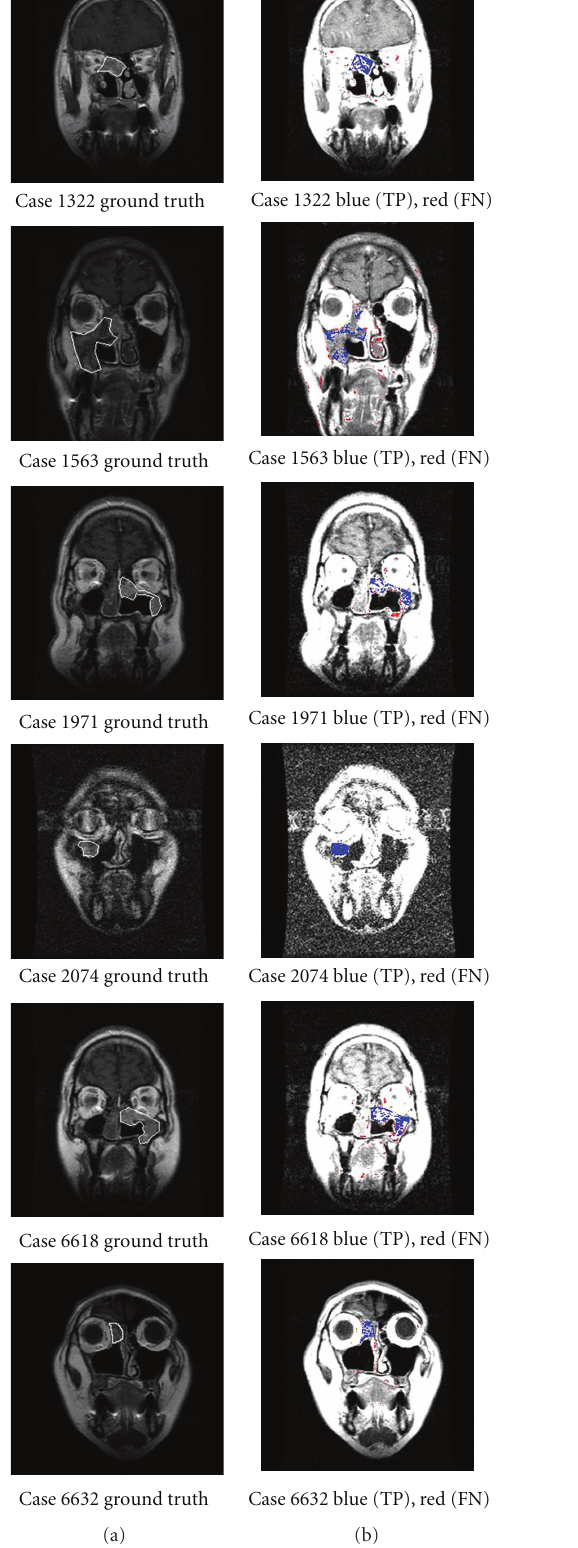
Figure 2: AdaBoost detection results. (a) Ground truth; (b) color blue is for true positive and color red is for false negative.